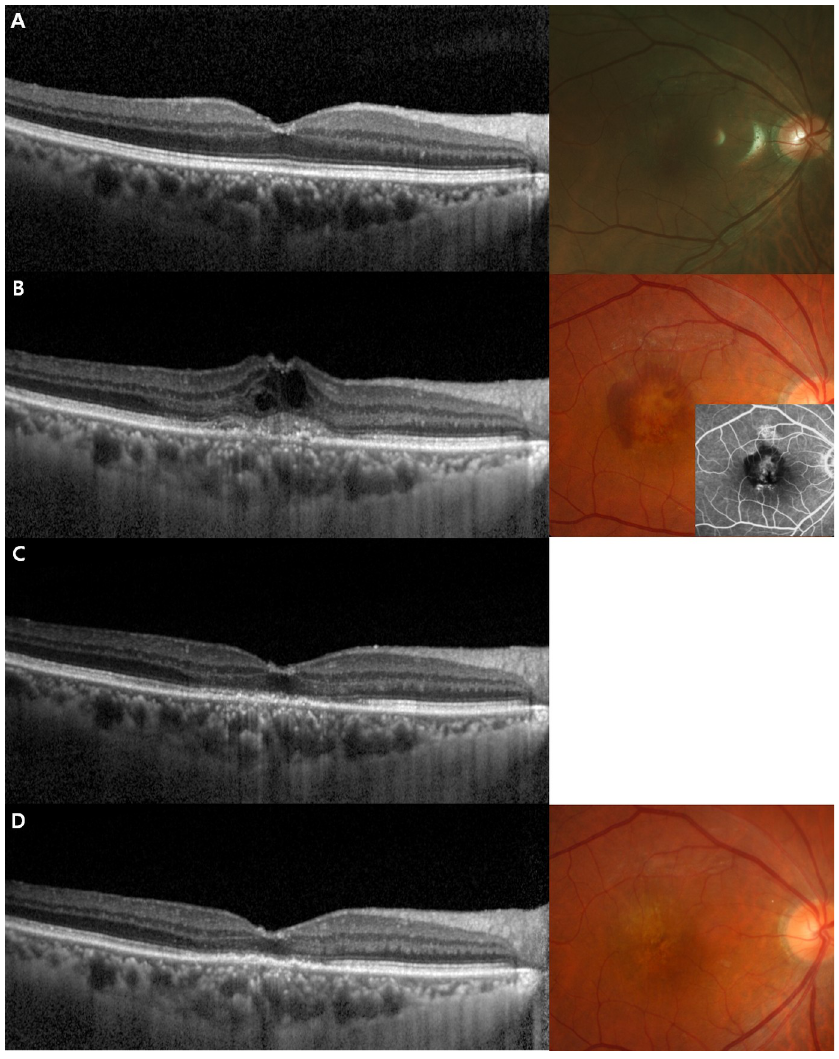
Fig 2. Representative images of a patient who responded to intravitreal anti-vascular endothelial growth factor (VEGF) agents after vitrectomy. (A) Optical coherence tomography (OCT) at 2 years after vitrectomy without neovascular age-related macular degeneration. (B) OCT and fluorescein angiography showing an active choroidal neovascular membrane at 3.6 years after vitrectomy. (C) Mild intraretinal fluid was observed at 1 month after the first anti-VEGF injection. (D) OCT showed a dry retina (absence of intraretinal or subretinal fluid) at 1 month after three serial injections.